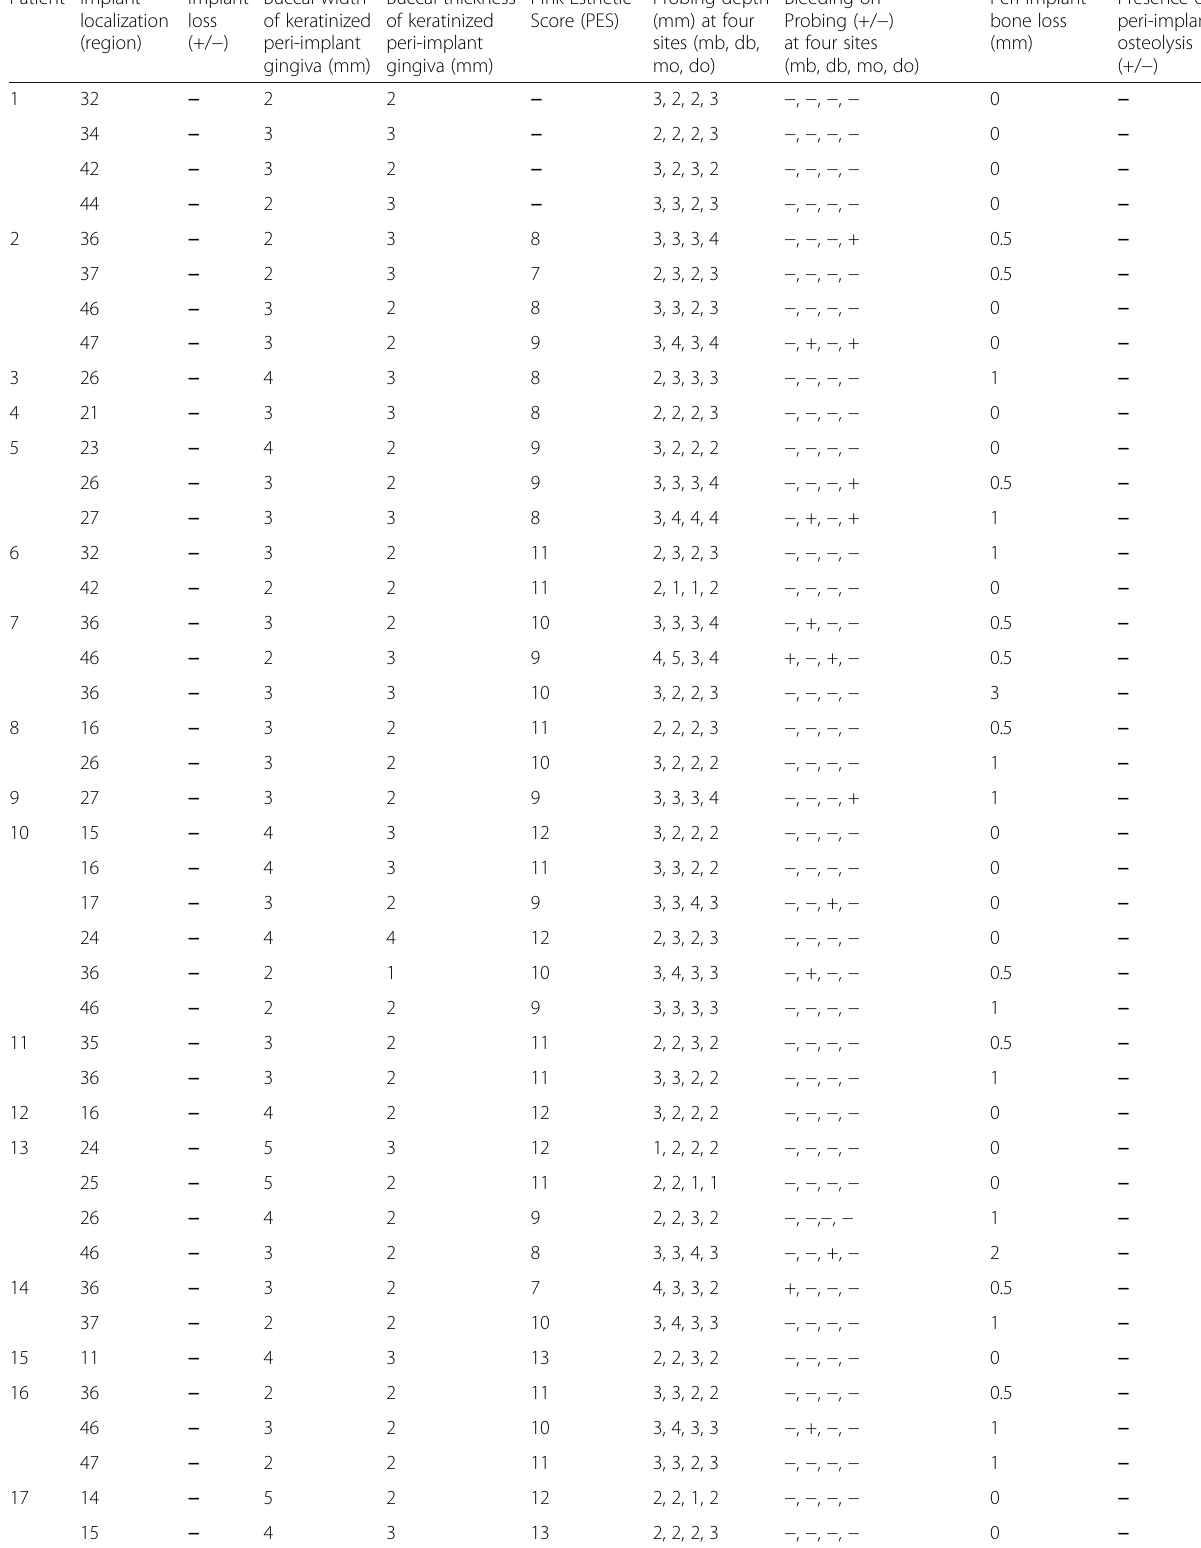
Table 2 Results from the clinical and radiological 3-year follow-up investigation Patient Implant-